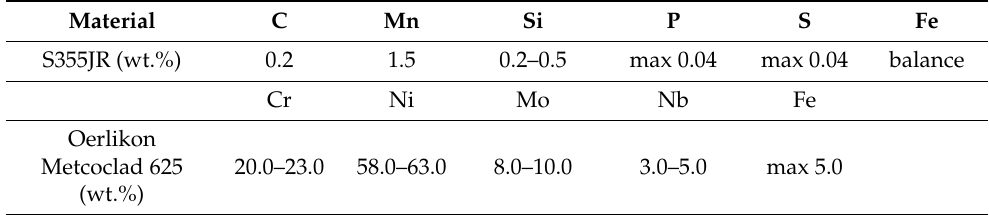
Table 2. Chemical compositions of substrate material S355JR and powder Metcoclad 625.